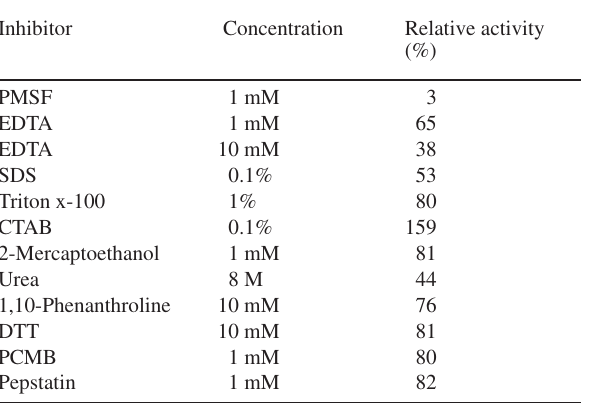
Table 3. Effects of chelators, detergents and inhibitors on purified protease activity.